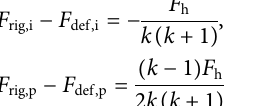
Frontiers in Built Environment |